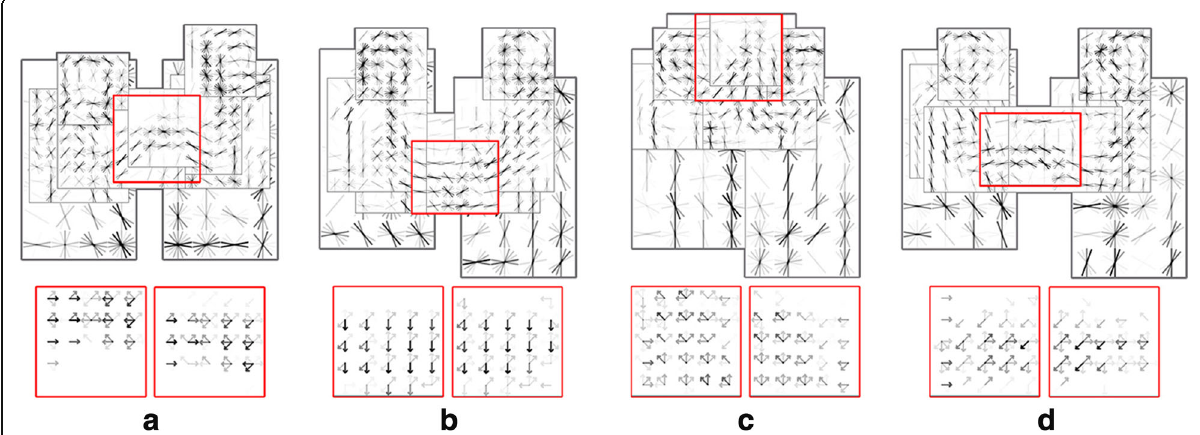
Fig. 4 Trained interaction models. The parts outlined in red represent the gradient features of the right hands. Below the part model, we show the motion features of these parts. a Fist bump. b Handshake. c High five. d Pass